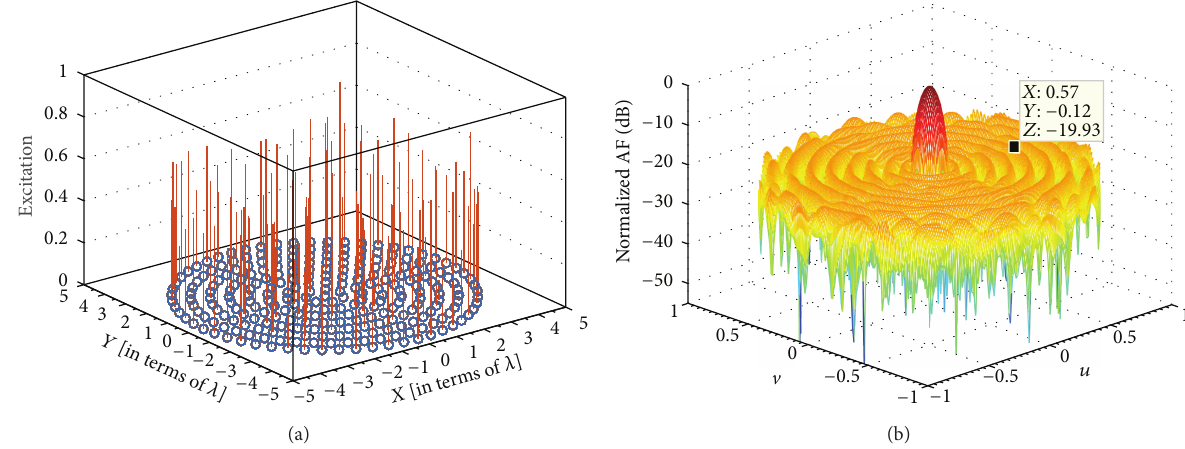
Figure 4: Nonuniform CCAA optimized by MTLBO for SLL reduction in regular space. (a) Configuration and excitation of a 130-element nonuniform array and (b) the related array factor with SLL = − 19.93 dB and FNBW = 0.13.